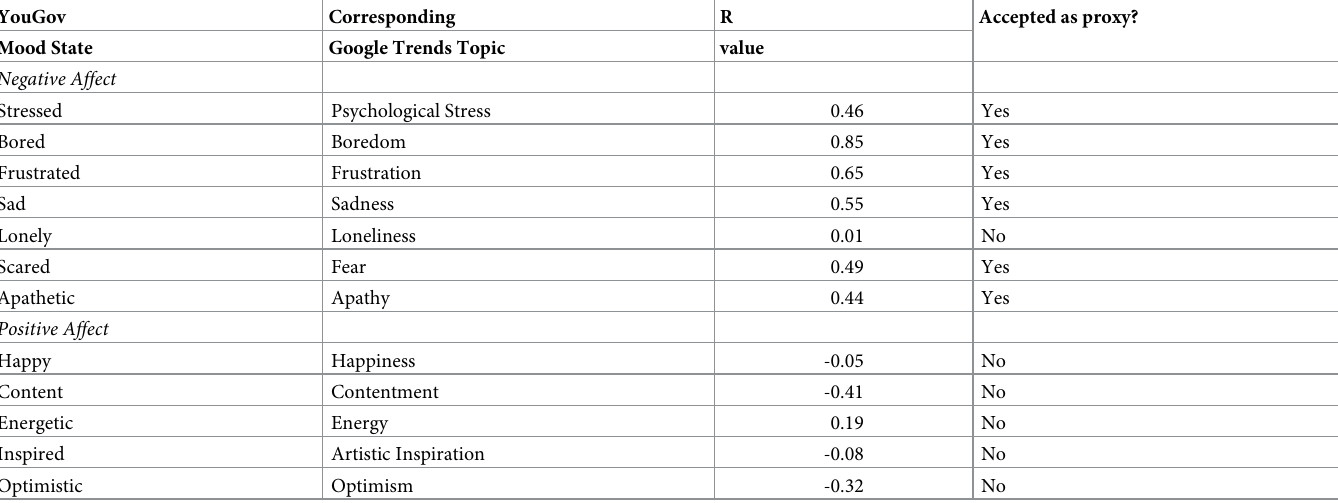
Table 1. Mapping of YouGov mood states to Google trends